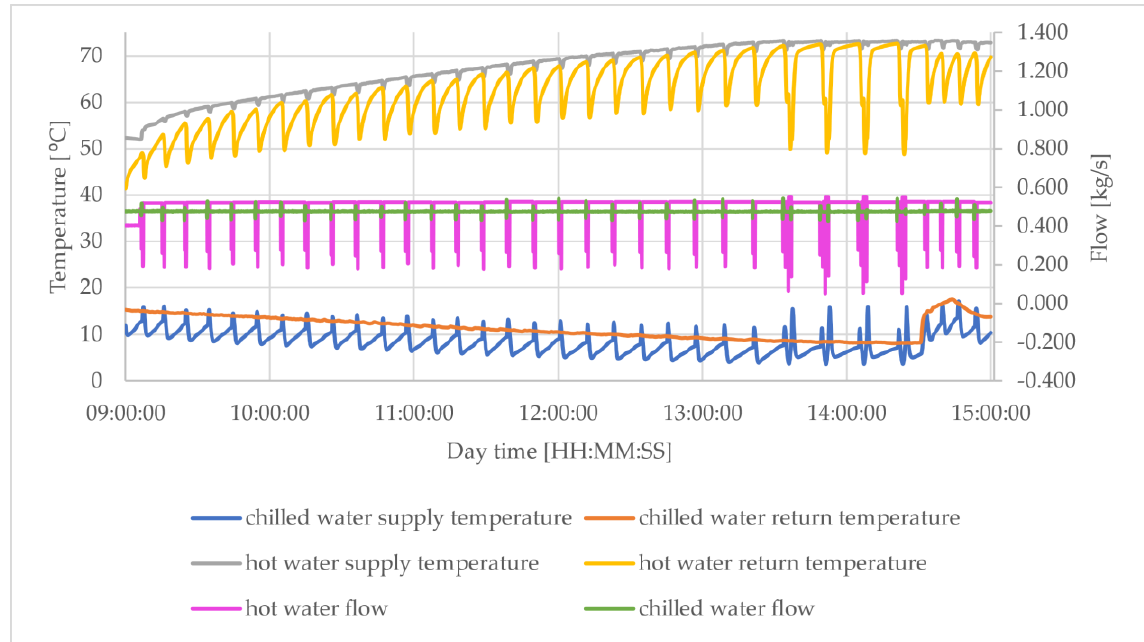
Figure 21. Measured values of temperatures and flow rates over time for 21st August.